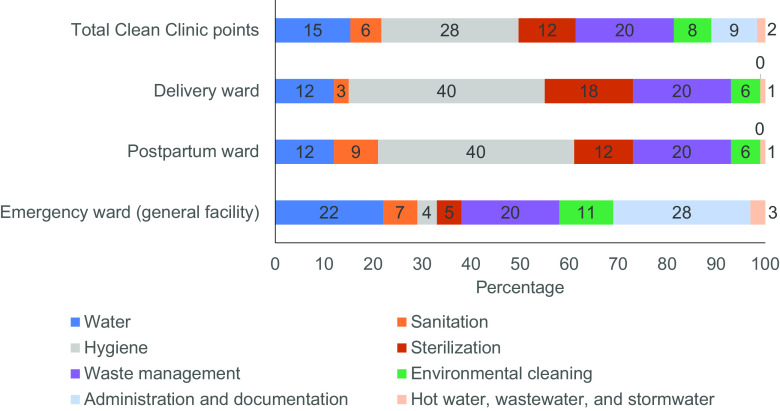
Guatemala Clean Clinic Assessment Scoring Distribution in Total, by Ward and Technical AreaaaTotal Clean Clinic score is based on the average between wards.